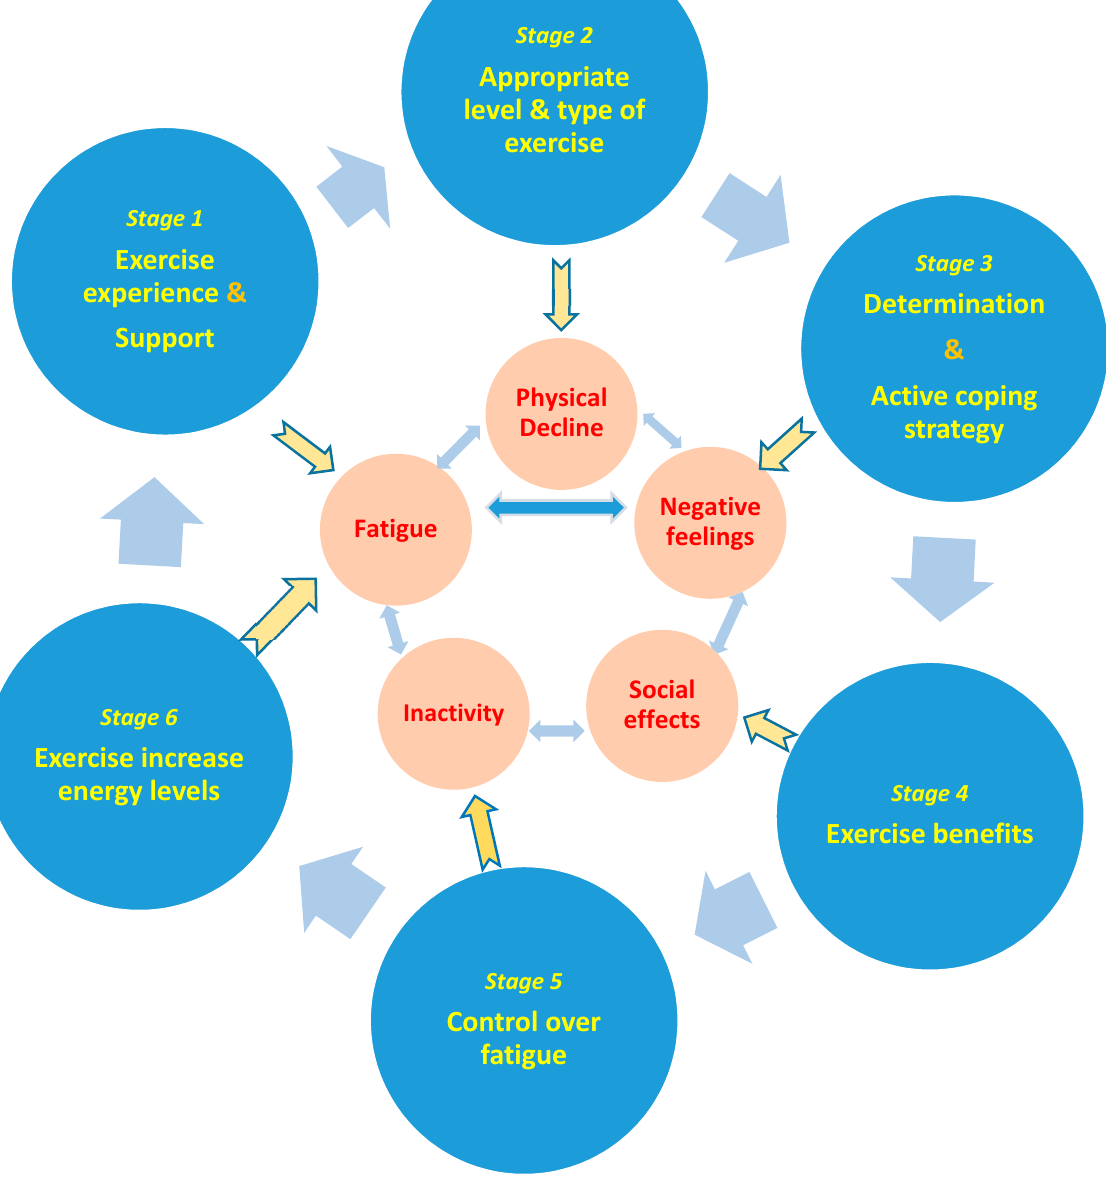
Figure 2. The model of exercise facilitation and inhibition.